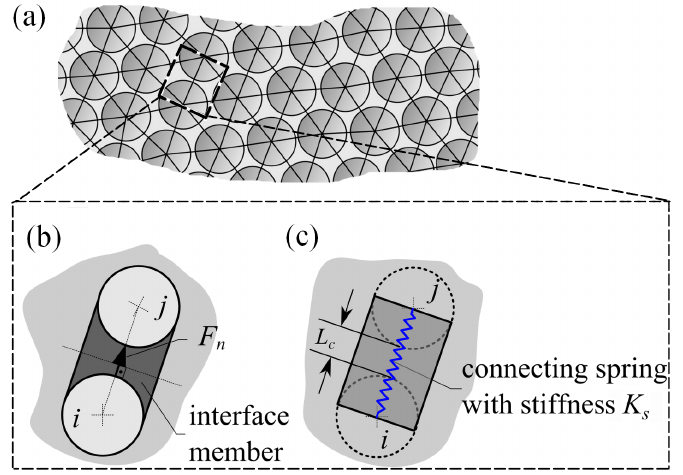
Figure 1. Modeling concept: a particulate composite with the conditional connecting element ( a ); a normal interaction of two spheres through a conditional interface member ( b ); and a spring representing the interaction of the spheres ( c